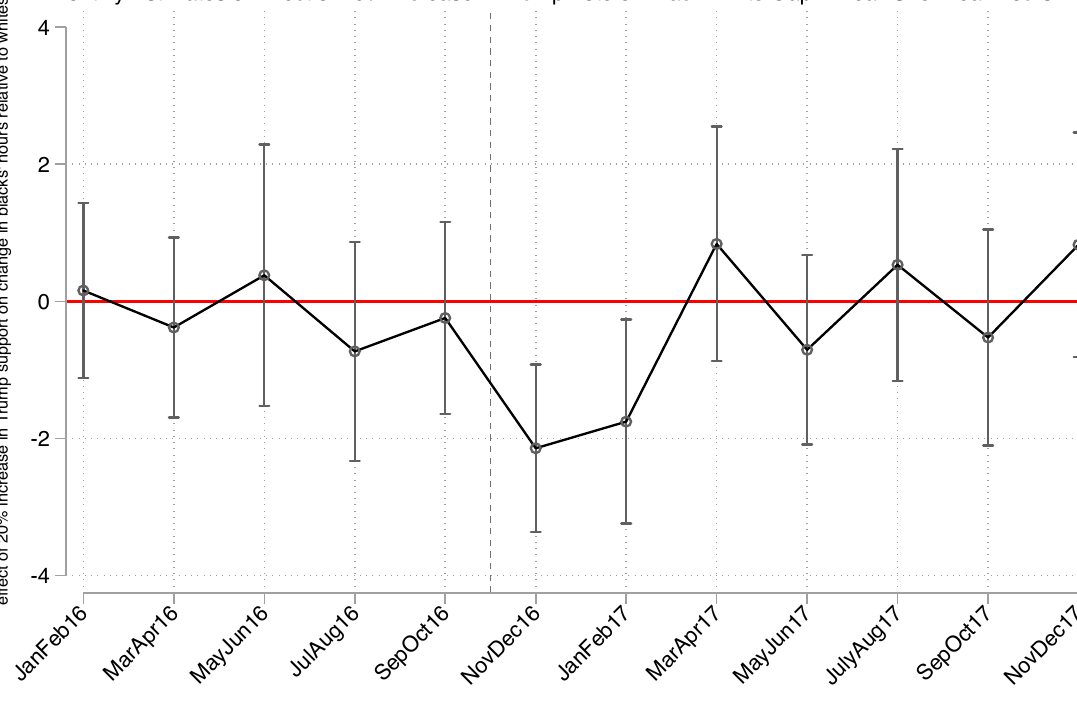
Figure 5: Evolution on the Trump effect: bimonthly estimates of Trump effect on racial disparities in trailing year-over-year weekly hours change. Notes: This figure shows bimonthly marginal effects estimates of 2016 Trump vote share variable on the black–white disparity in year-over-year changes in weekly hours worked. Estimates are based on rolling, two-wave LDV models, using sample of prime-age hourly workers employed in the same job year-over-year from January 2015 to December 2017. Models include CBSA, industry, and occupation fixed effects. Probability weights are applied to adjust for survey design, sample attrition, and attrition from wave 1 hourly job. Standard errors are clustered by